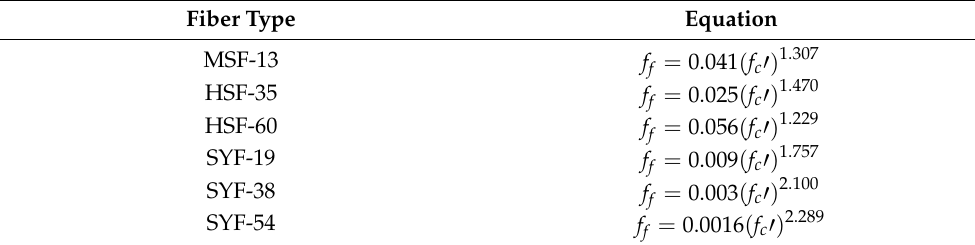
Figure 11. Relation between the compressive and flexural strengths of ( a ) MSF-13, ( b ) HSF-35, ( c ) HSF-60, ( d ) SYF-19, ( e ) SYF-38, and ( f ) SYF-54. Table 11. Summary of compressive strength and flexural strength